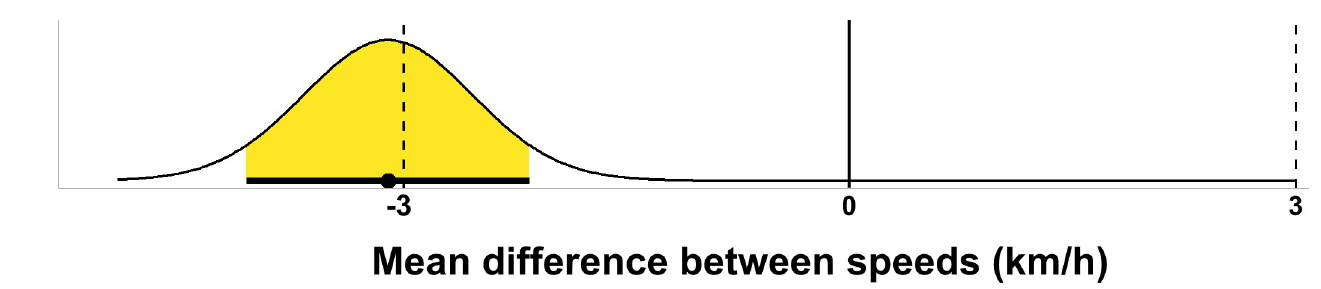
Fig 1. Consonance density plot of the difference between the two speeds, combining all experimental conditions. Note. The yellow area indicates the 90% confidence intervals from the two one-sided tests procedure. The dashed vertical black lines indicate the equivalence bounds (in raw scores) and the vertical black line indicates the nil null